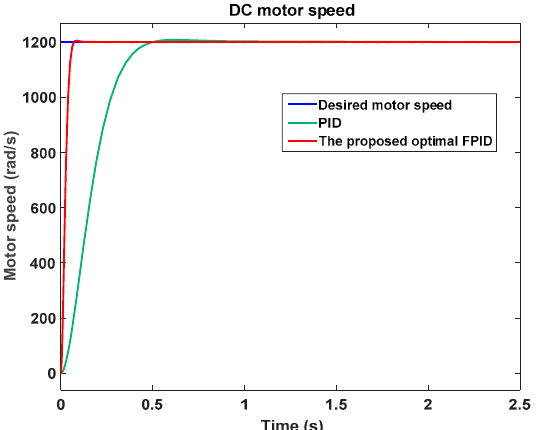
Table 4. The eight optimized parameters.